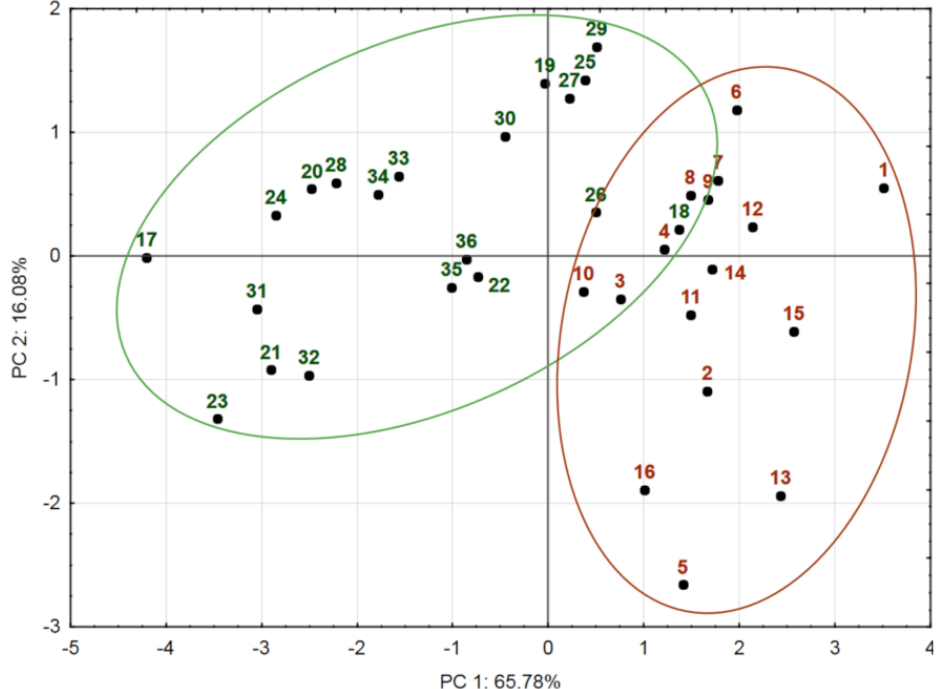
Figure 2. PCA2 score plot model representing the accumulation of total phenolic acids and flavonoids in Achillea millefolium plant materials from Turkish (No. 1–16) and Lithuanian (No. 17–36) populations. Inflorescence, leaf, and stem datasets were pooled together and used for PCA2. Scores marked in brown indicate Turkish populations; scores marked in green indicate Lithuanian